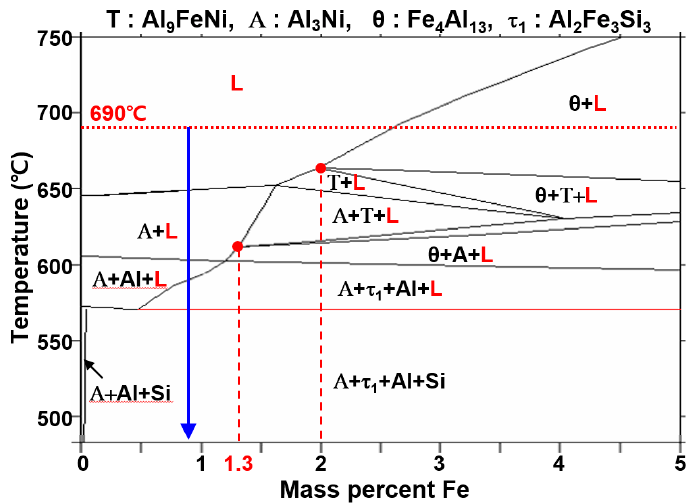
Figure 4. (Al-7Ni-6Si)-xFe (max. 5%) pseudo-binary phase diagram calculated using Thermo-Calc TM software.